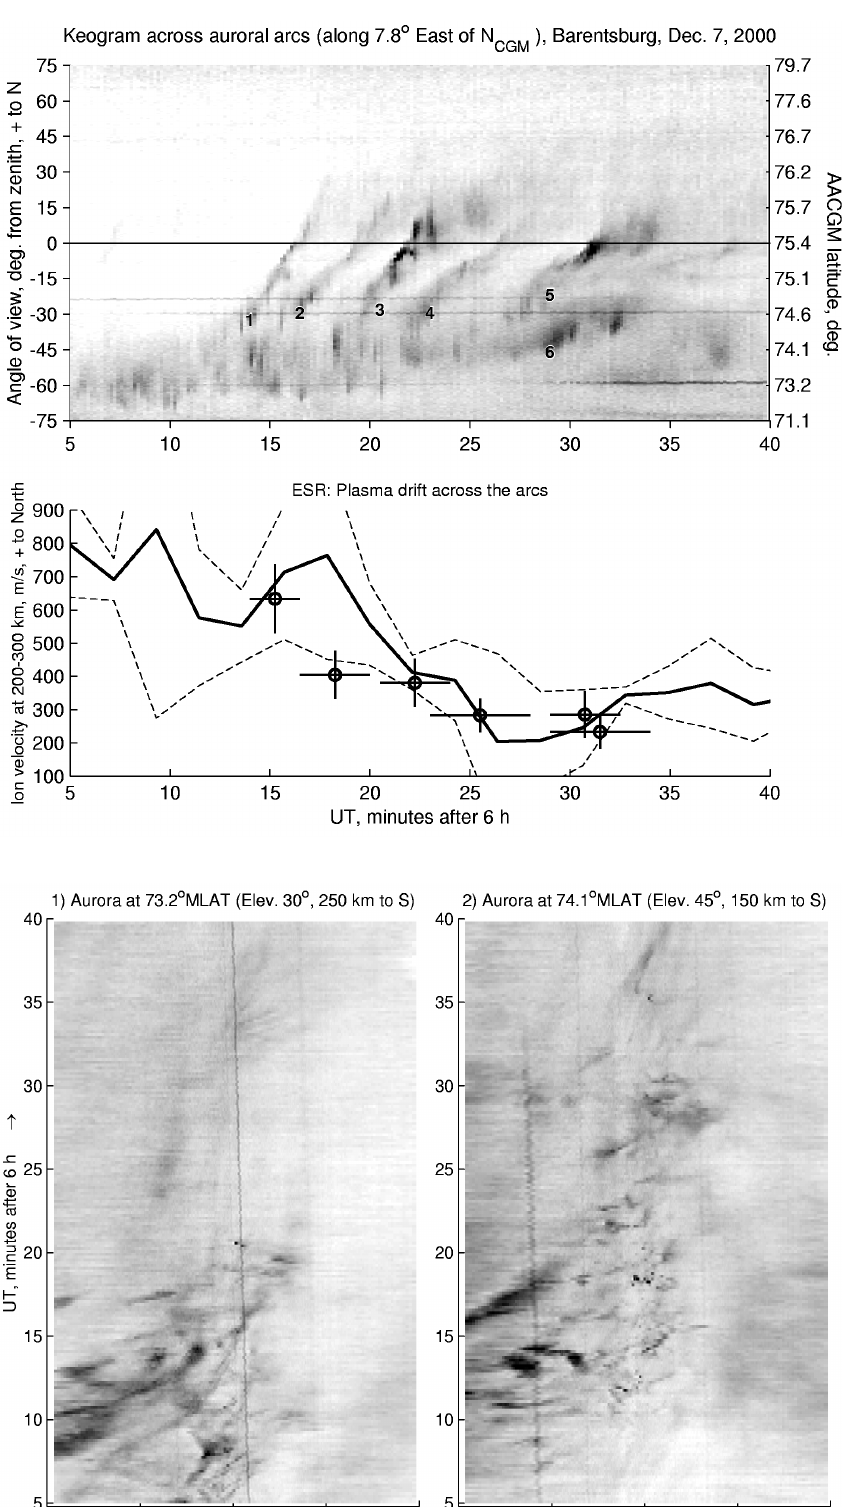
Fig. 6. Two keograms made along the averaged stretching of the arcs, at ele- vations of 30 ◦ and 45 ◦ to the horizon, which lines are shown in Fig.